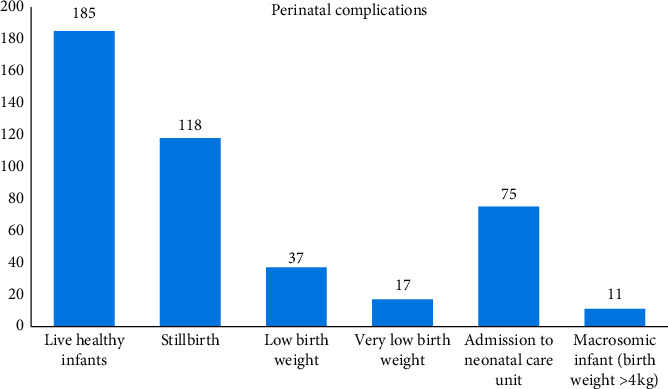
Bar chart showing the perinatal complications.